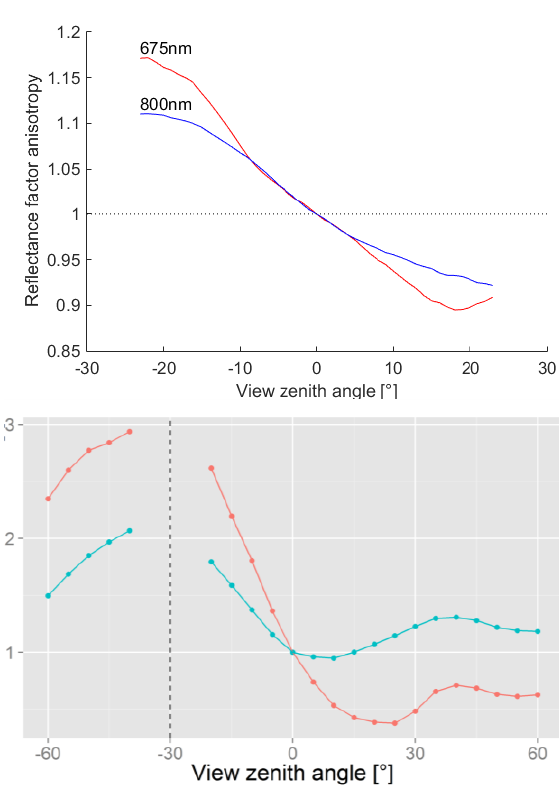
Figure 4. Reflectance anisotropy of sugar beet field in the solar principal plane as measured by the HYMSY ( top ) and the goniometer ( bottom ). Sun/lamp zenith angle in both datasets is 30° Figure 3. UAV flight path over the sugar beet field in the 2014 experiment.